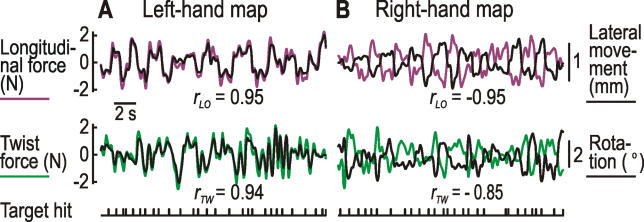
Influence of Mapping Rule on Tool Movements during Performance with Left-Hand and Right-Hand MapsSuperimposed time traces of longitudinal force and lateral tool movement (upper panels) and of twist force and rotational tool movement (lower panels) from a single participant during the last 20 s of target chasing in the first experiment;
r
LO and
r
TW indicate hand-asymmetry indices for longitudinal and twist forces. Bottom trace represents instances of target hits (spikes). For the last 20 s of runs by all participants and mapping rules, the slope coefficients of the linear regressions indicated that the tool moved 0.84 (0.28–1.23) mm/N longitudinal force and rotated 0.84 (0.36–1.42) °/N twist force (median and 25th–75th percentile). The corresponding values for the 30-s periods of target chasing for which fMRI data were analyzed (see
Figure 5A and
5B), where the wrists of the participants were strapped, were 0.28 (0.19–0.68) mm/N and 0.63 (0.42–1.04) °/N.